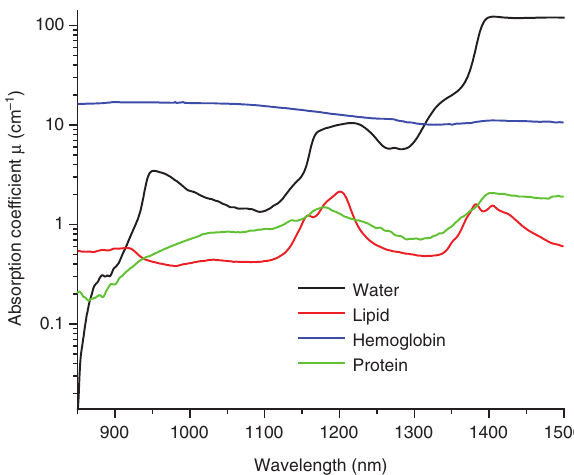
Figure 4: Absorption spectra of major endogenous tissue chromo- phores: water, hemoglobin, protein (represented here by albumin), and lipids (with permission from